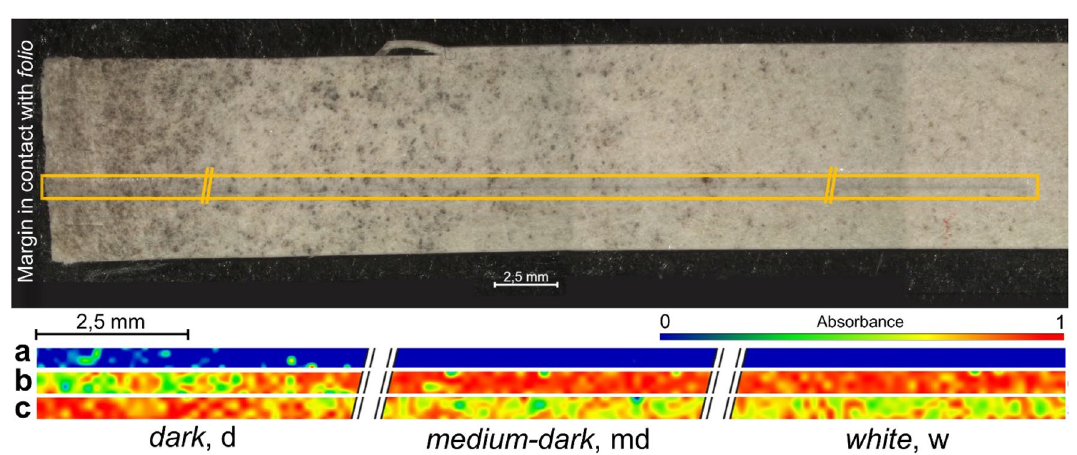
Figure 6. µATR imaging of passepartout sample 2 (“ Folio 843 and its passepartout ”). Top: image of the fragment where µATR imaging was performed, the total size of the fragment is around 6 × 0.7 cm; the 38 × 0.4 mm measured area is highlighted by the yellow box where the imprinting of the Ge crystal on the paper is visible; bottom: contour maps of peaks of ( a ) PVAc at 1740 cm −1 , ( b ) cellulose at 900 cm −1 and ( c ) starch glue at 1027 cm −1 . Images show the normalized absorbance in a fake color